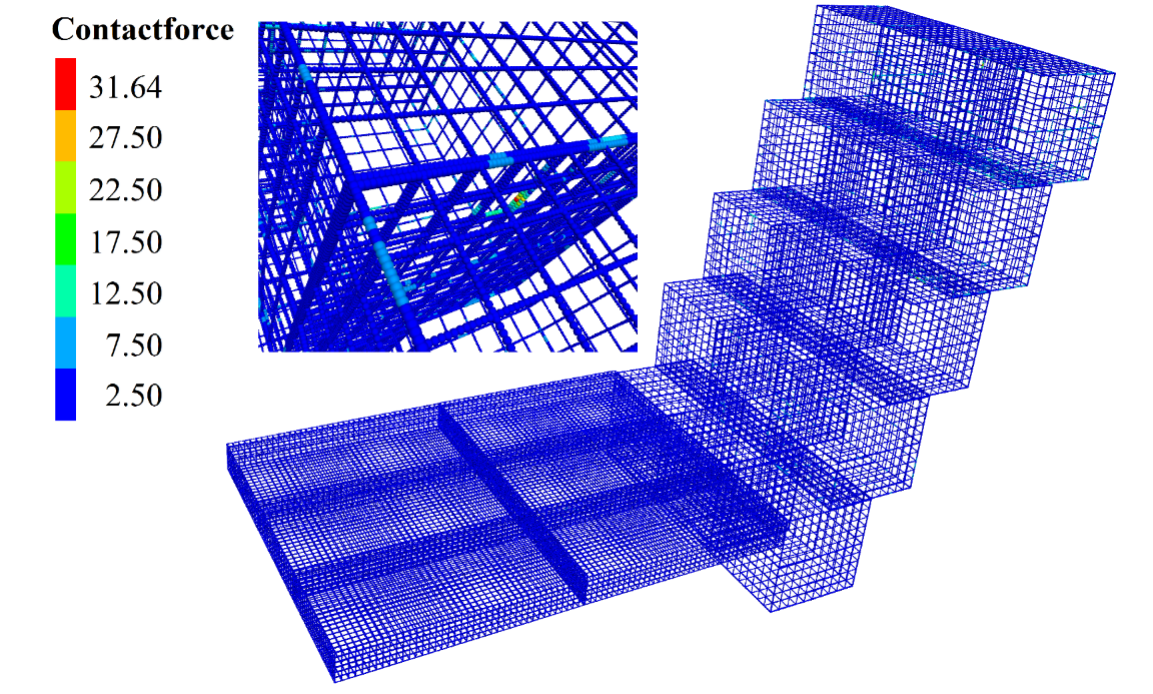
Figure 18. Contact force of the BFRs. The unit of contact force is N.